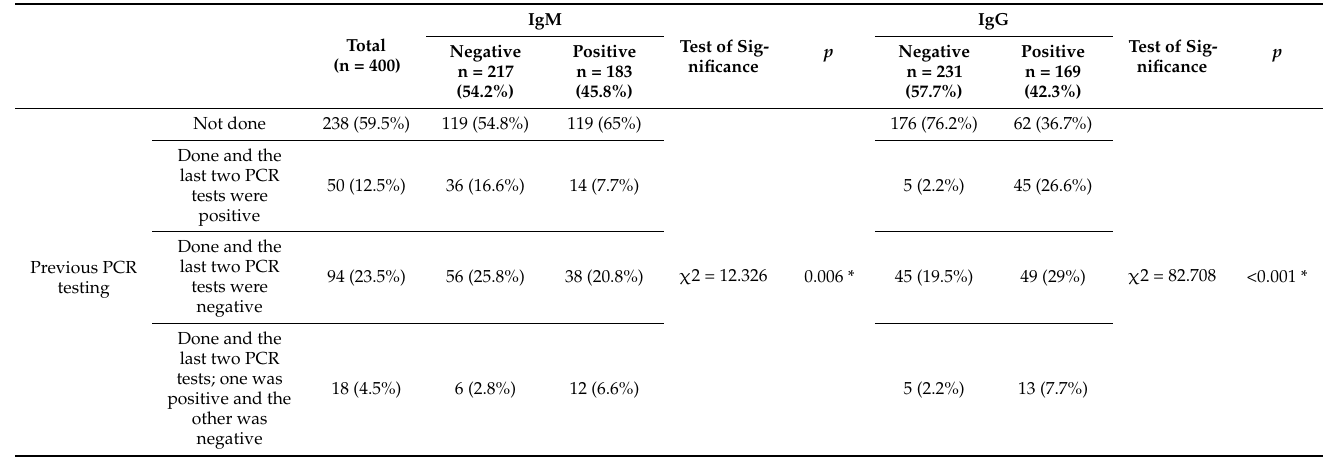
Table 1. The previous PCR results of the participants stratified for expression of anti-SARS-CoV-2 IgM and/or IgG in their blood. Data shown are frequencies; n. (%), and mean ± SD (median;